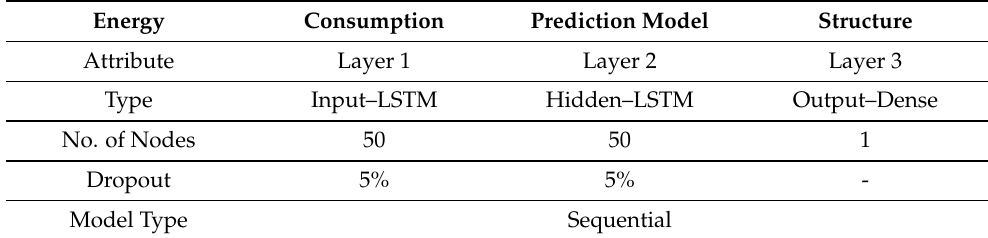
Table 3. GrAb : LSTM-based prediction